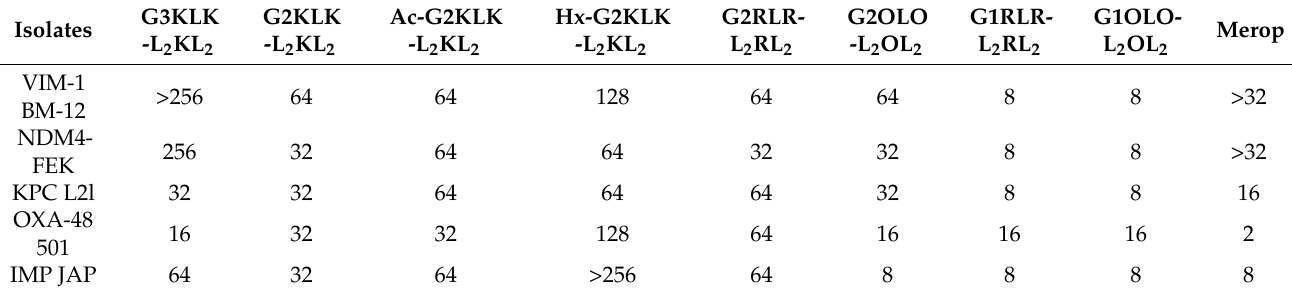
Table 5. MIC ( µ g/mL) values of the SCPDs tested on CRE, E. coli